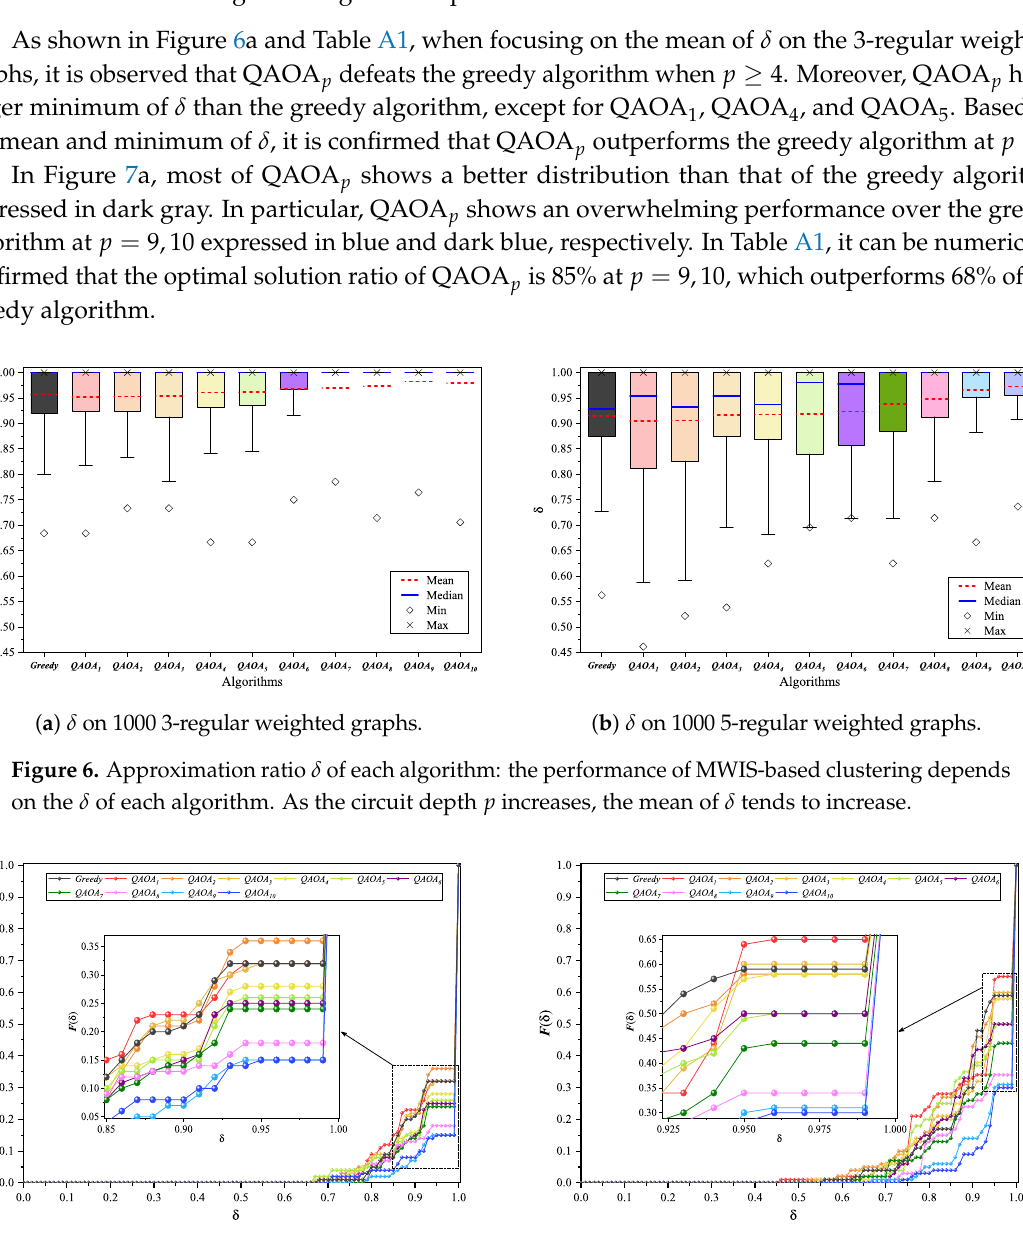
( a ) F ( δ ) on 1000 3-regular weighted graphs. Figure 7. Cumulative distribution function F ( δ ) : the accuracy of MWIS-based clustering heavily depends on the ratio of δ = 1. In general, the ratio of δ = 1 tends to increase as the circuit depth p